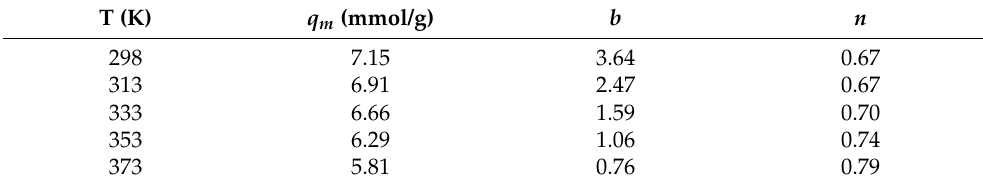
Table 7. Constant values of the Sips isotherms of CO 2 adsorption on Li 0.61 Na 0.39 X.